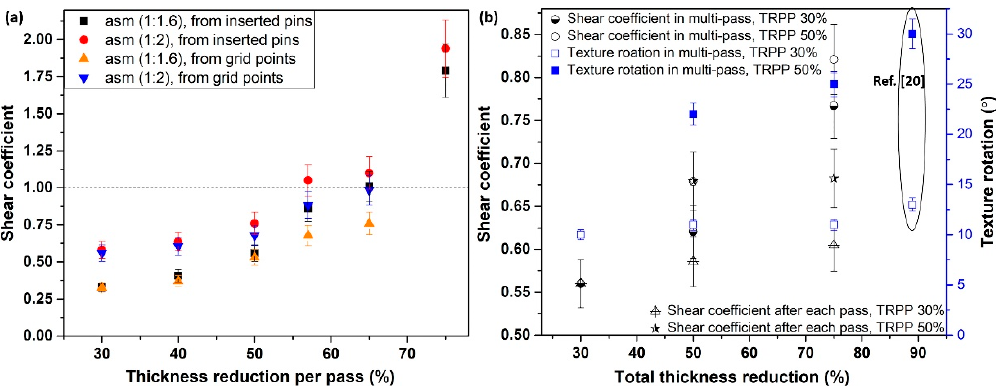
Figure 12. ( a ) Shear coefficient measurement in the mid thickness area of a sheet for single pass rolling with TRPP of 30–75% and asymmetry ratios 1:1.6–1:2, and ( b ) for a total thickness reduction of 75% in multi-passes with TRPP of 30% and 50% at the asymmetry ratio of 1:2.